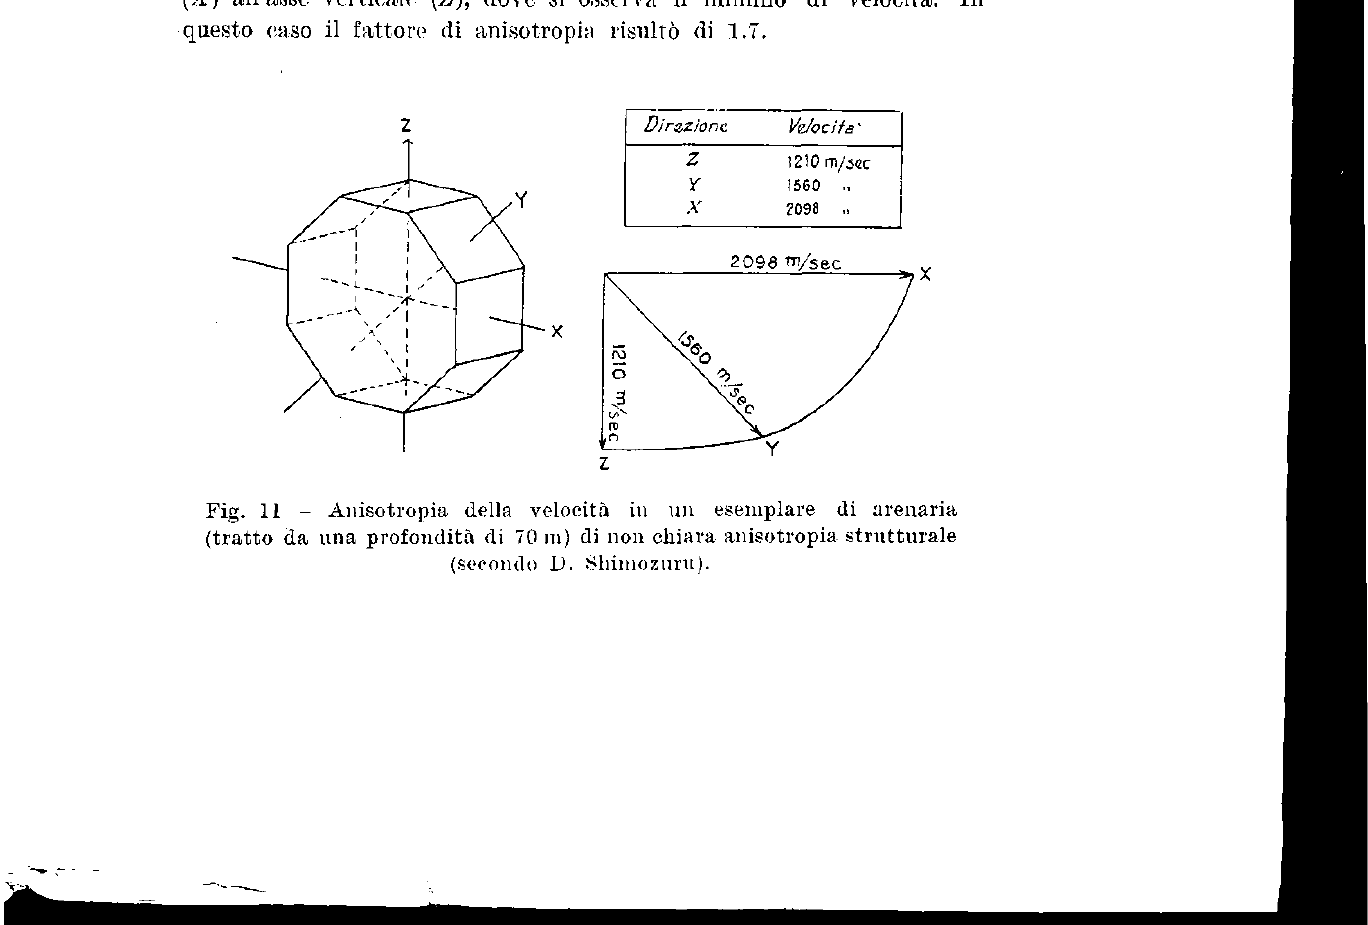
Fig. 11 - Anisotropia della velocità in un esemplare di arenaria (tratto da una profondità di 70 ITI) di non chiara anisotropia strutturale (secondo D.